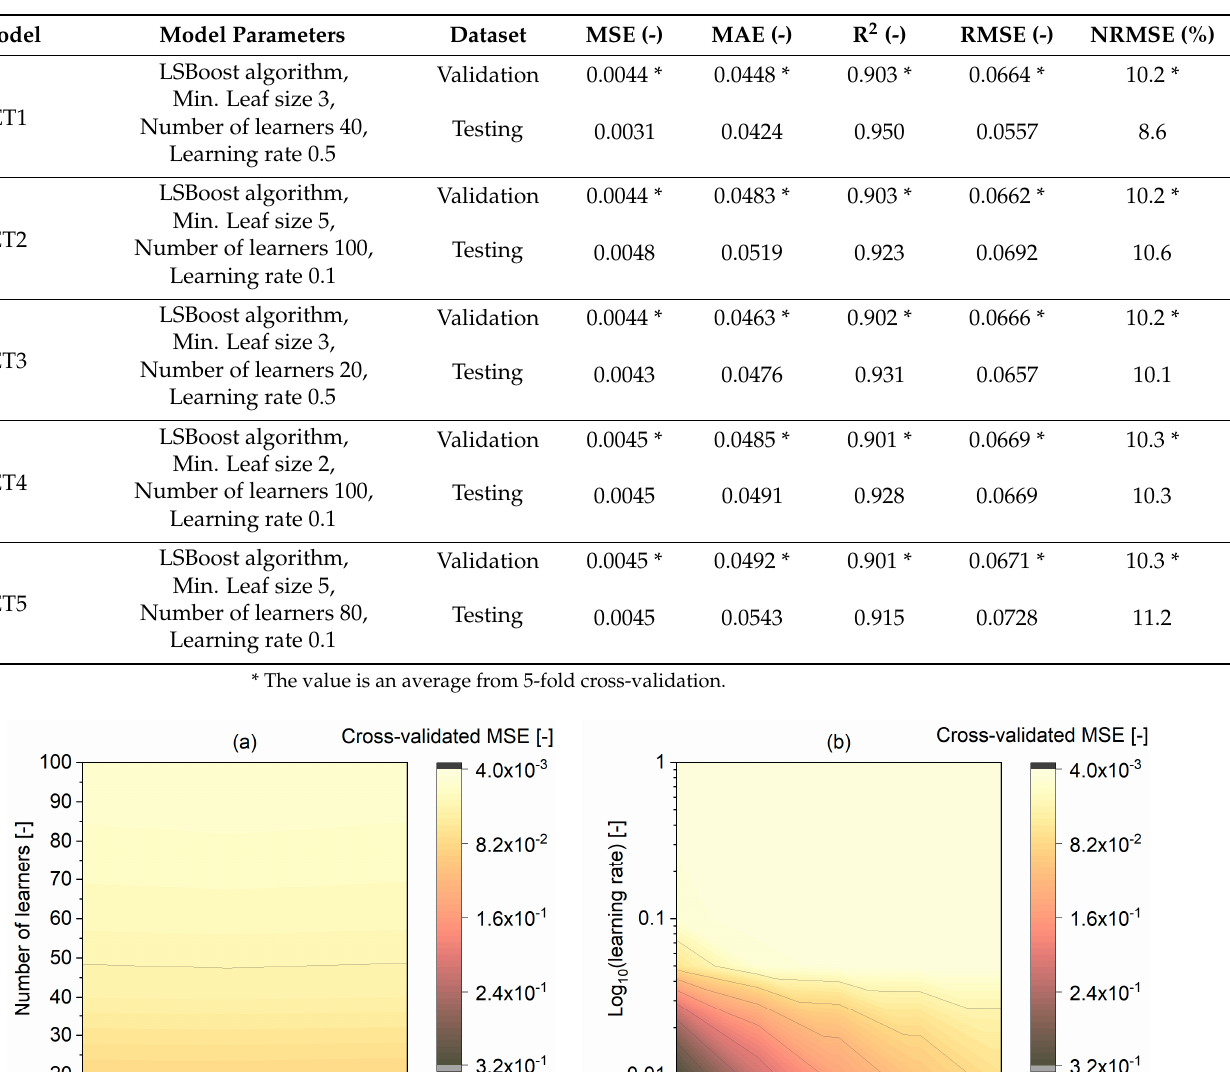
Table 6. Prediction performance of five best-performing models.